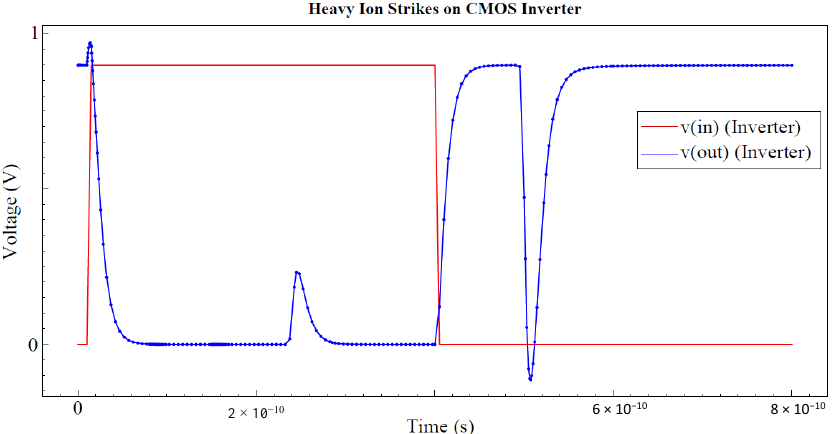
Figure 3. Transient plot of a CMOS Inverter when two heavy ions strike the NMOS and PMOS transistor at different time moments.